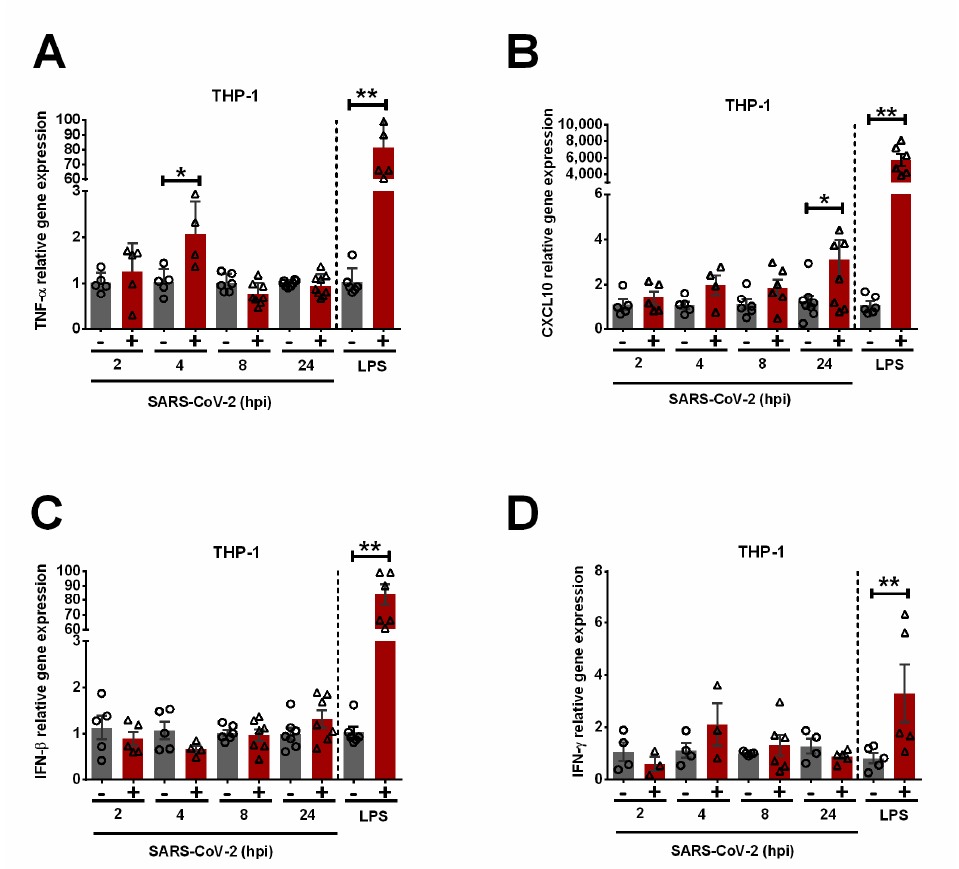
Figure 3. Low-grade pro-inflammatory response in SARS-CoV-2-exposed human THP-1 macrophages in the absence of productive virus replication. RT-qPCR was used to detect relative gene expression of TNF- α ( A ), CXCL10 ( B ), IFN- β ( C ), and IFN- γ ( D ) in SARS-CoV-2-inoculated THP-1 macrophages. LPS-treated macrophages (100 ng/mL, 4 h) were used as positive controls. Error bars denote the standard error of the mean (SEM) from 2 to 3 biologically independent experiments. hpi = hours post-infection. * p < 0.05, ** p < 0.01 was determined by two-way ANOVA adjusted by Sidak’s multiple comparison test.